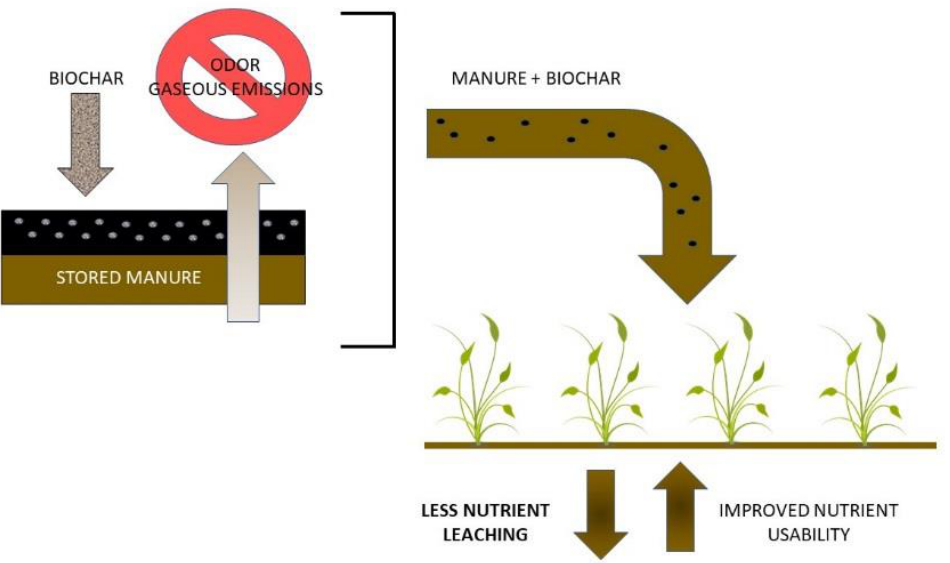
Figure 1. Concept of sustainable animal and crop production system—the proposed role of biochar. (Stage 1) Surface-applied biochar to manure mitigates short- and long-term emissions of odor and gaseous pollutants, retaining more nutrients in the manure. (Stage 2) Manure-biochar mixture is used as a value-added fertilizer, improving soil organic matter, nutrient utilization by plants, and lowering nutrient runoff risk.